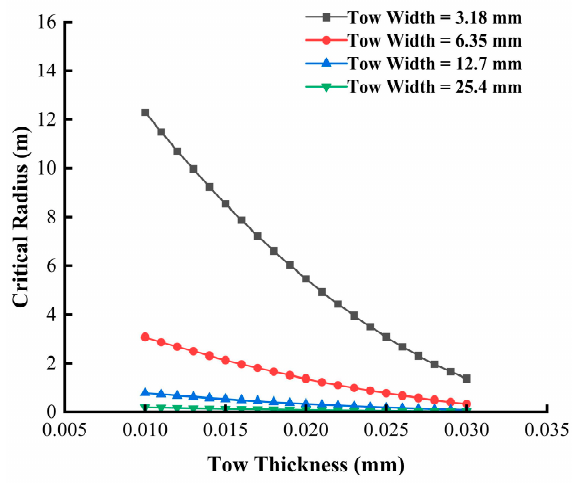
Figure 12. Critical steering radius of the tow plotted against thickness.